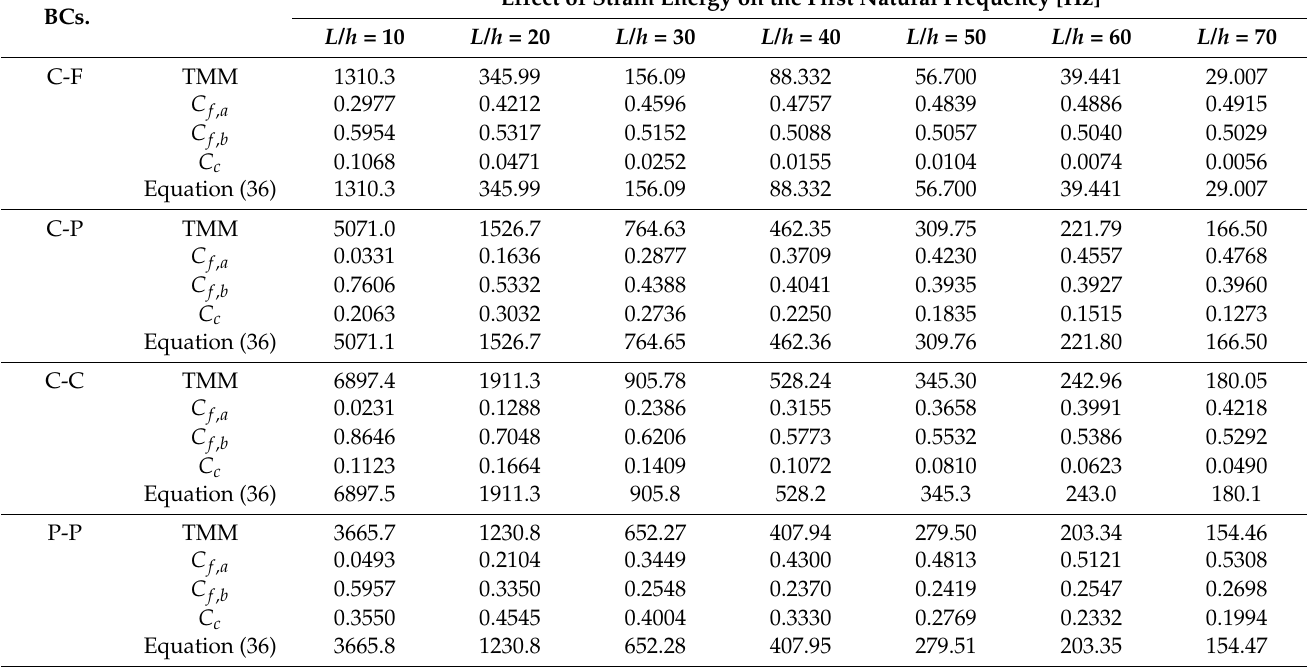
Table 4. Effect of strain energies on the first natural frequency of three-layered beams with different end conditions depending on the variation in L/h.